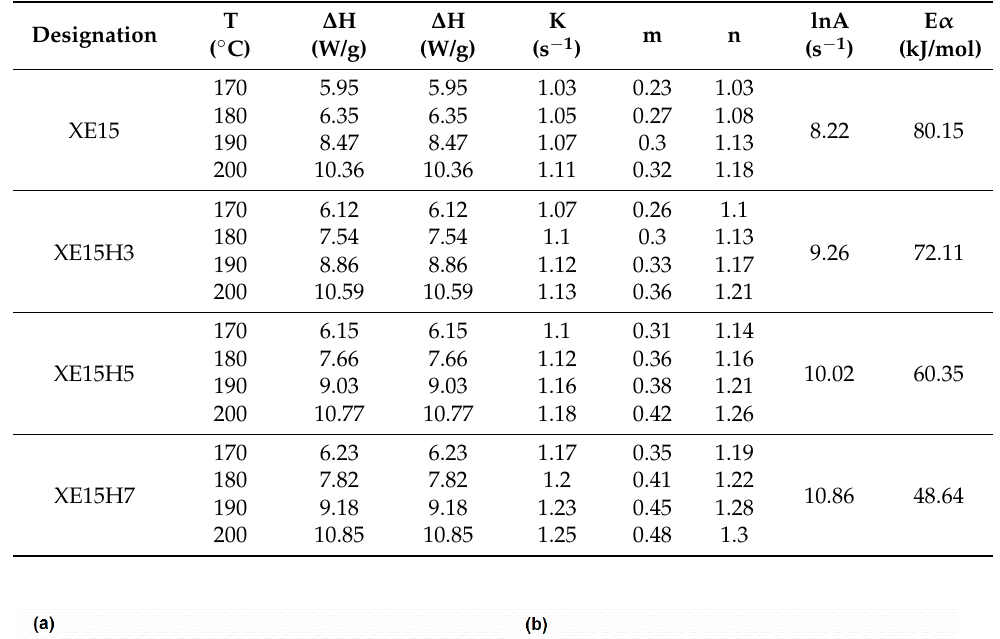
Table 5. Vulcanization kinetic parameters for various XNBR/epoxy/XHNT nanocomposites calcu- lated through using the autocatalytic approach and isothermal DSC curves.